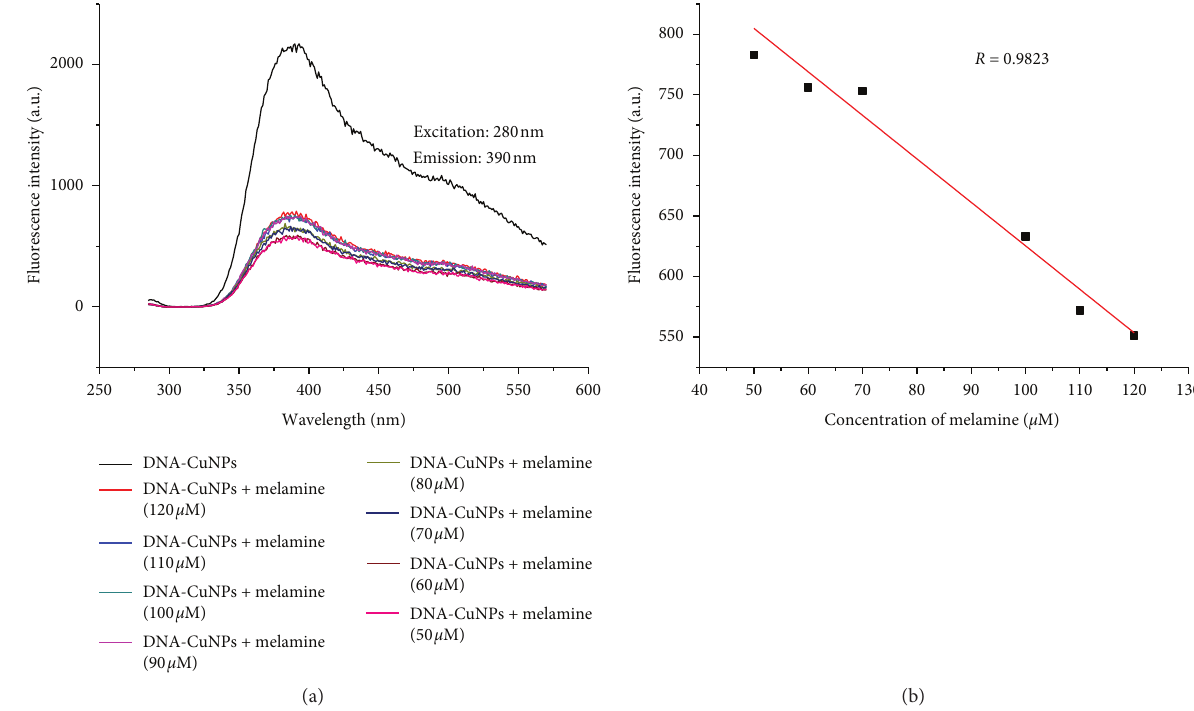
Figure 4: Fluorescence spectra of detection of melamine by DNA-Cu